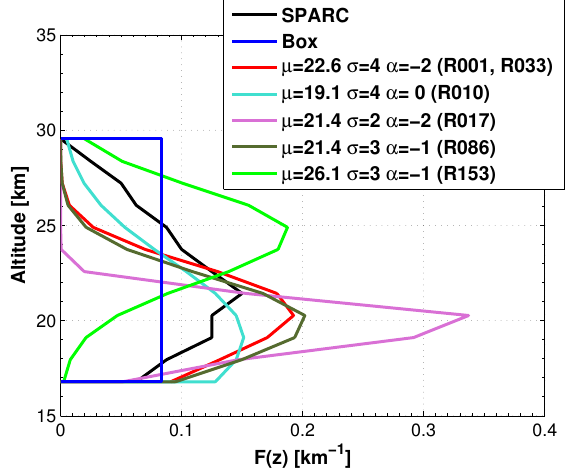
Figure 1. Vertical distribution function F(z) . Black line: used in SPARC (2006). Blue line: uniform (box) profile that distributes SO 2 homogeneously with altitudes. Each of these curves encloses a unit